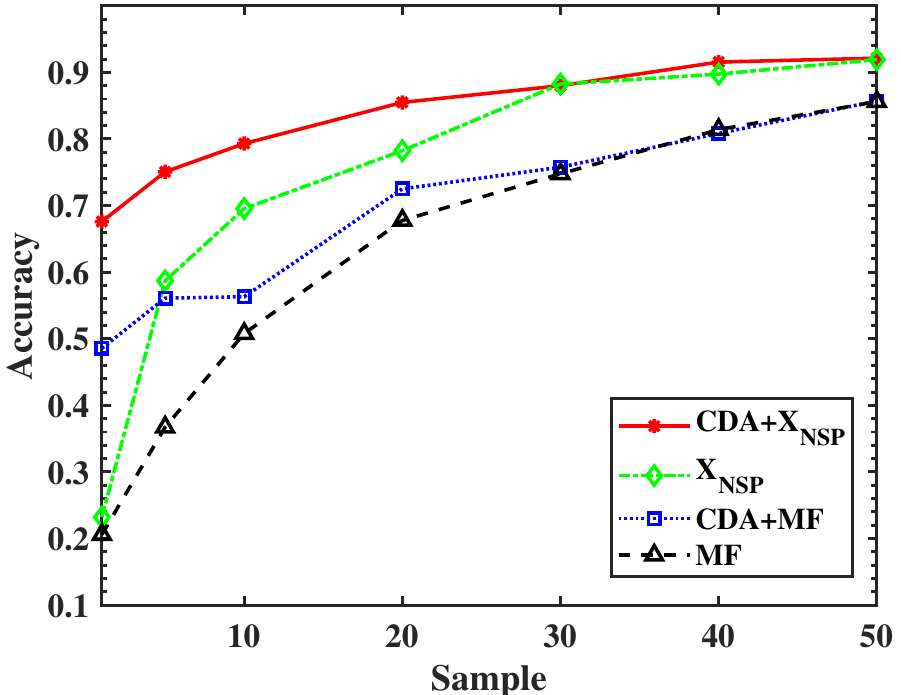
Figure 9. Experimental results of different training samples based on MF-based image and sparse image under